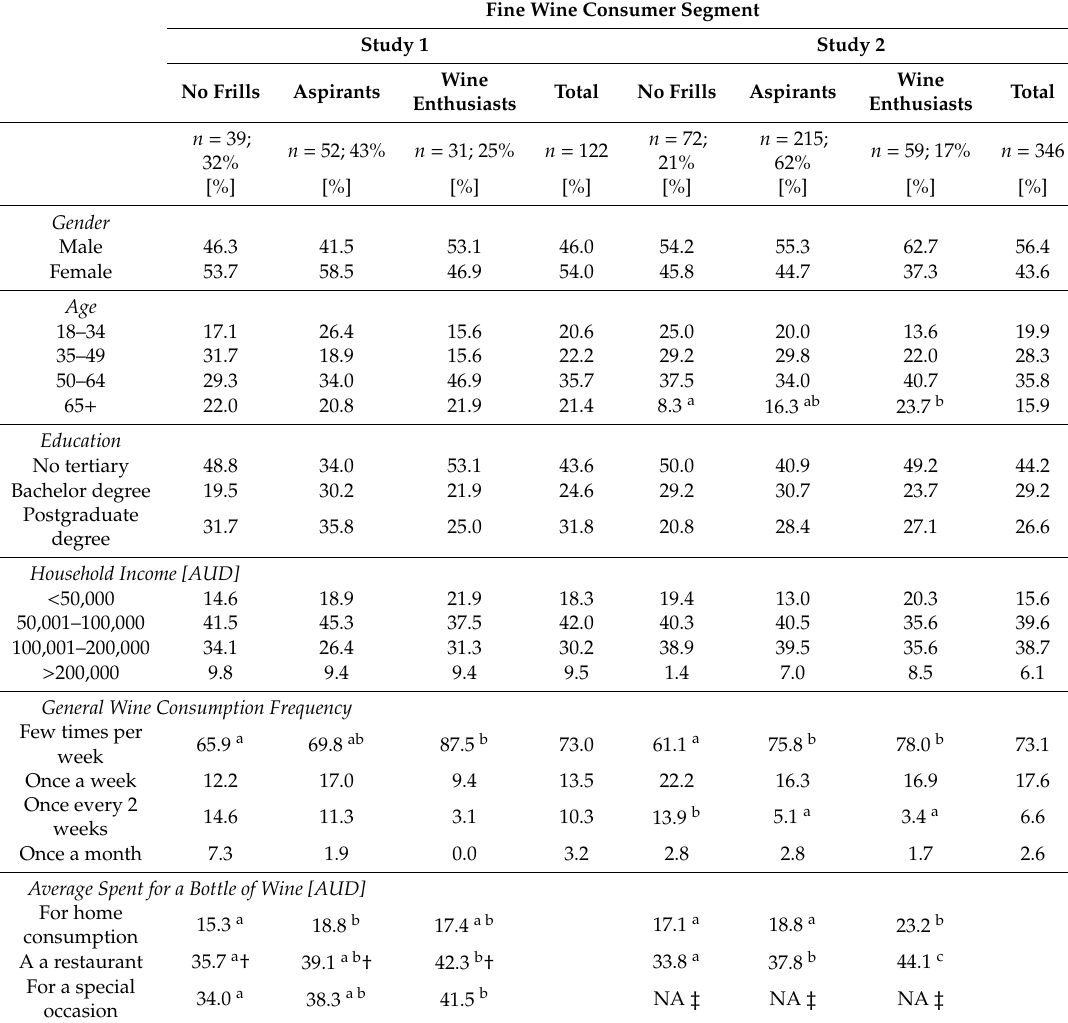
Table 2. Demographic data and wine consumption frequency of the three fine wine segments. Fine Wine Consumer